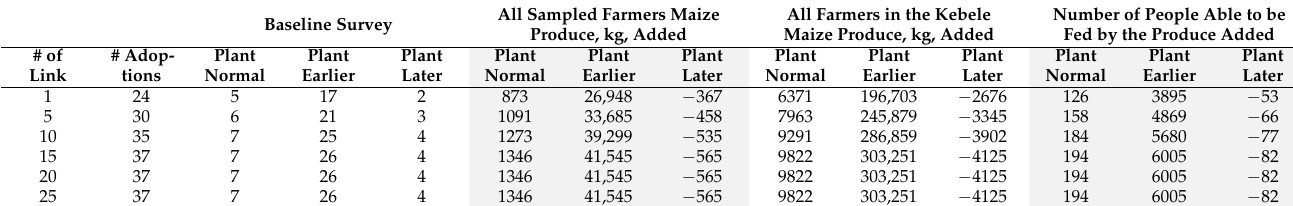
Table A5. Adoption rate of farmers’ interactions with other farmers through networks, crop produc- tivities of adopted numbers, and number of people able to be fed under more rain conditions. Baseline Survey